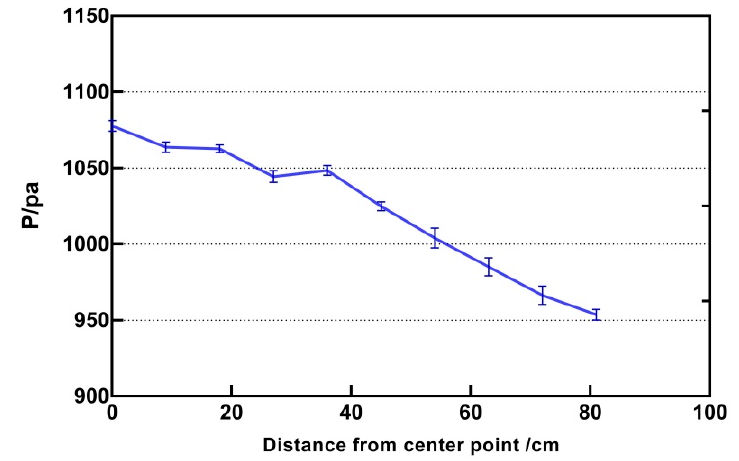
Figure 6. The relationship between the distance from centre point and the output intensity. When studying the influence of the height parameter, a similar experiment was conducted, keeping the frequency at 240 HZ, keeping the distance from the centre at 0 mm, and setting the input intensity to 1. Experiments found that there were many interference points between ultrasonic waves in areas with a height of less than 9 cm, and the perception of the focus with the hand will be greatly interfered with. The spatial perception of heights above 25 cm will be weakened, which is not conducive to tactile perception. The working area should be set between 9–25 cm. It is observed from experimental Figure 7 that the relationship between the two is non-linear, and the output pressure intensity will decrease as the height